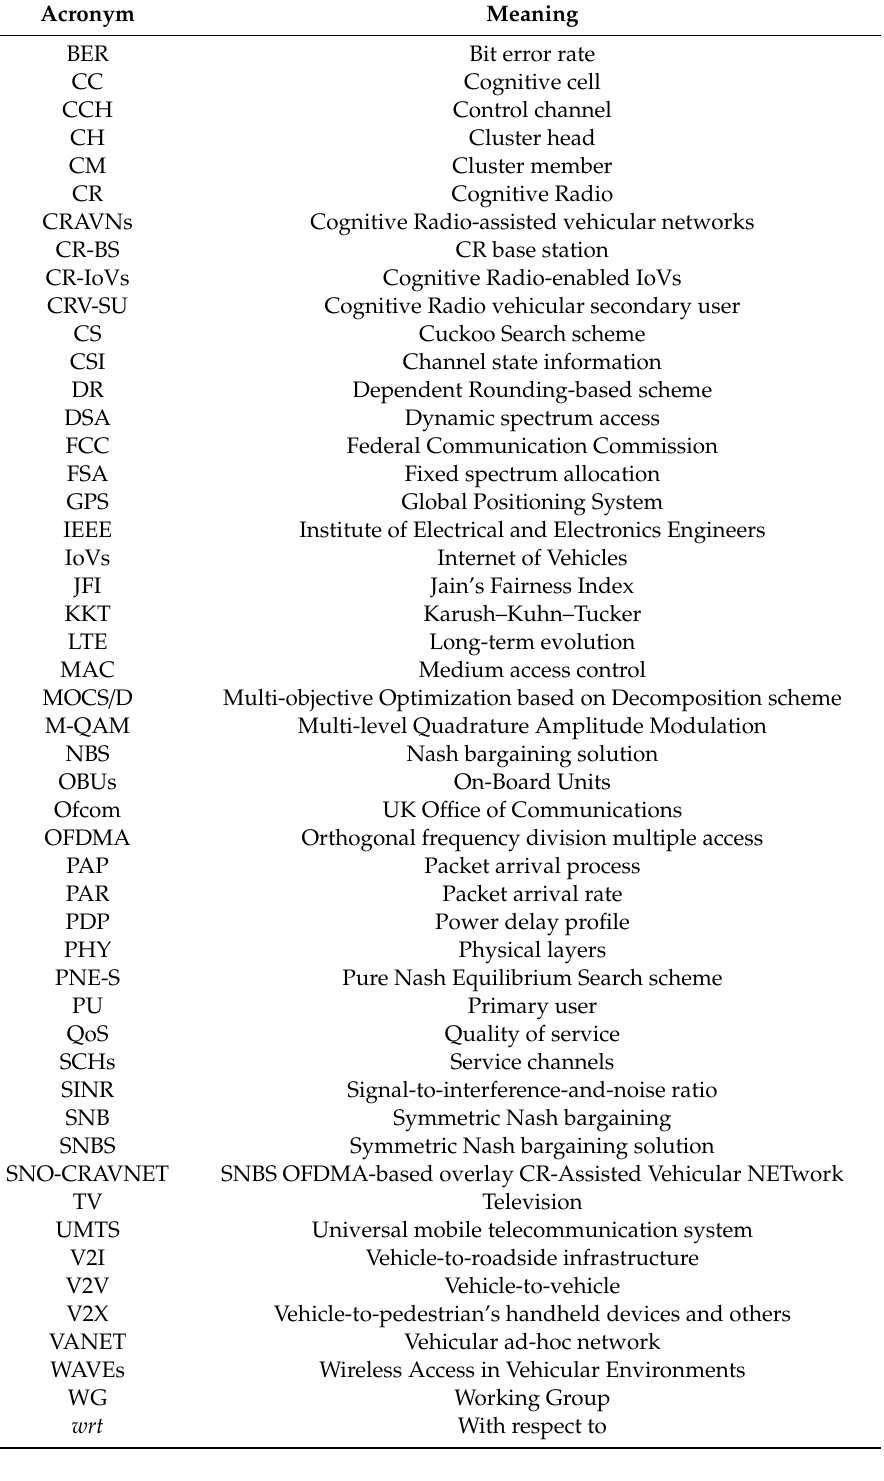
Table 2. List of